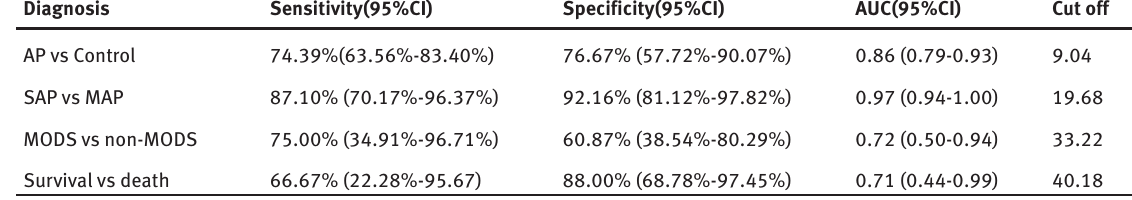
Table 2: Diagnosis performance and corresponding cut off value.